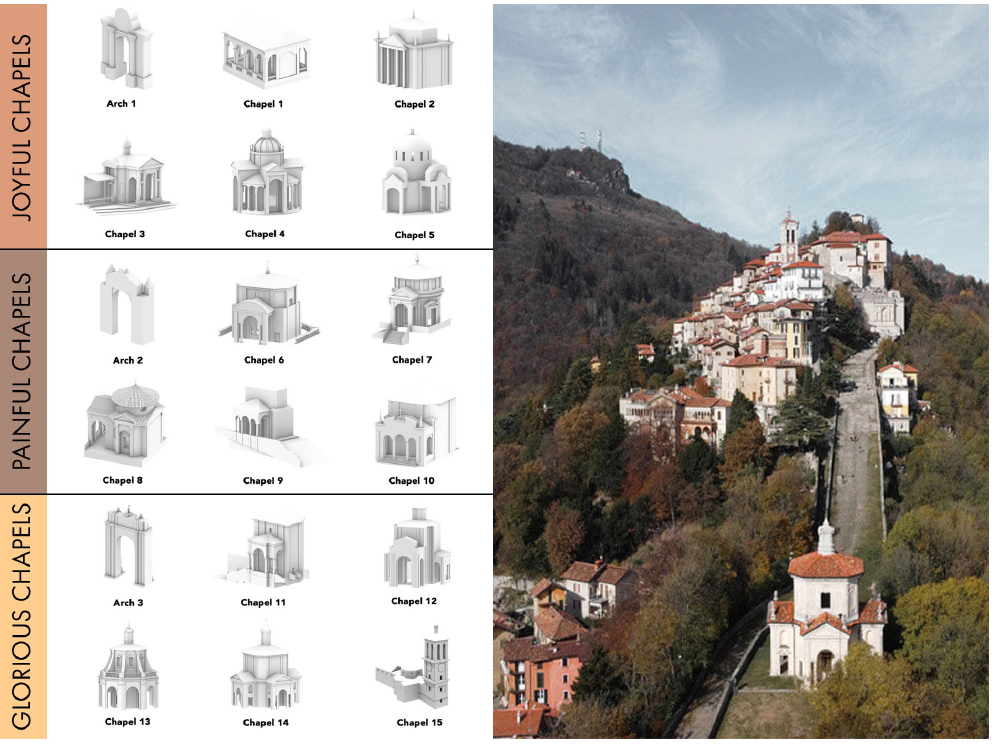
Fig. 3 Abacus of chapels and arches composing the Sacro